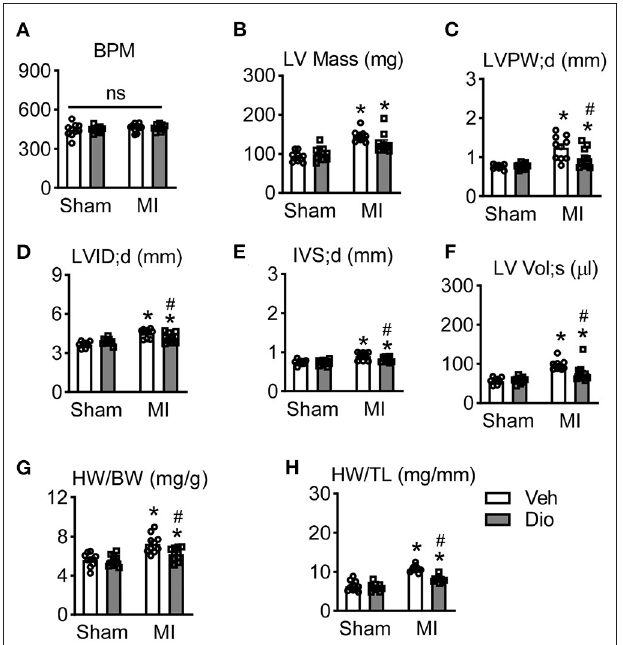
FIGURE 3 | Dioscin prevents cardiac remodeling in response to myocardial infarction. (A) The analysis of beat per minute (BPM). Echocardiographic parameters of (B) left ventricular mass (LV Mass; mg), (C) end-diastolic left ventricular posterior wall (LVPW; d, mm), (D) end-diastolic left ventricular inner diameter (LVID; d, mm), (E) end-diastolic left ventricular septum (IVS; d, mm), and (F) left ventricular end-systolic volume (LV Vol; s, µ l). (G) The ratio of heart weight to body weight (HW/BW; mg/g). (H) The ratio of heart weight to tibia length (HW/TL; mg/mm). n = 10 each group. Data are mean ± SEM. * P < 0.05 vs. sham group, # P < 0.05 vs. MI group.